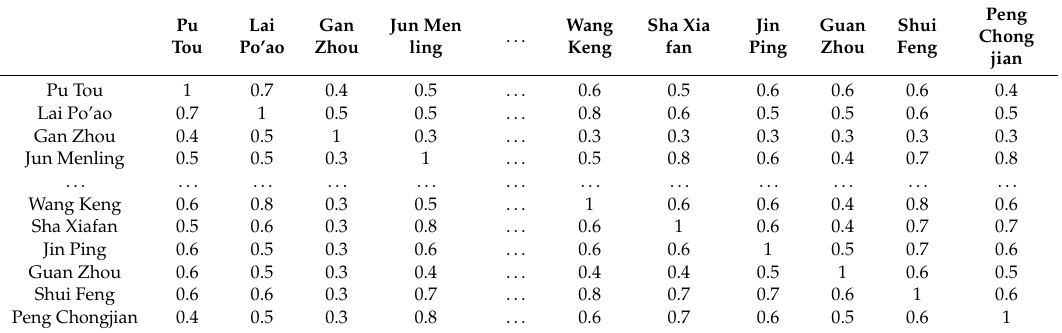
Table 4. Clustering Connected Triple Similarity (CTS) matrix based on small and medium watershed dataset.